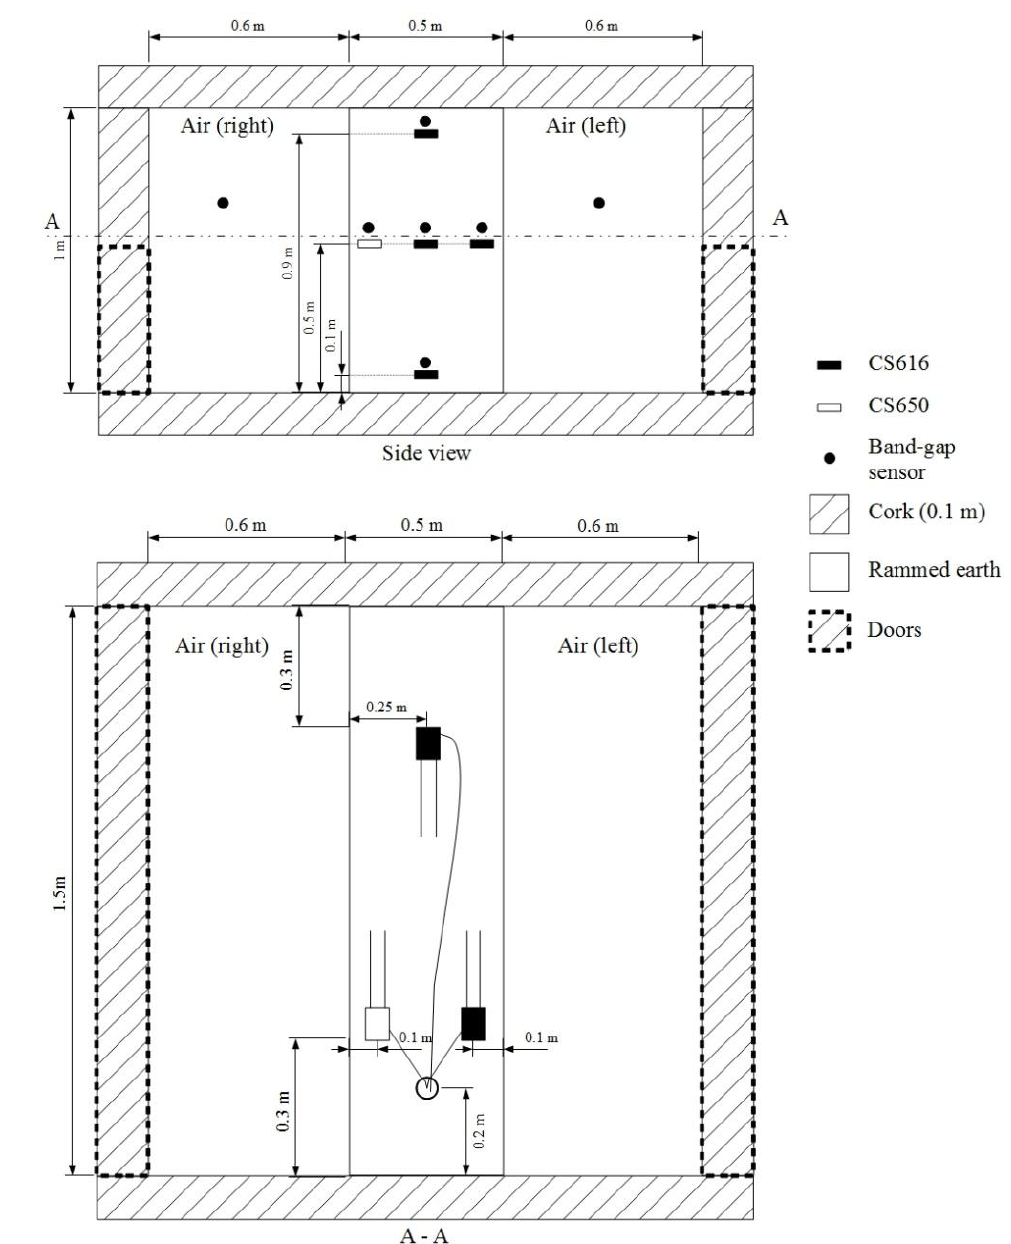
Figure 4. Side view and top view of the implementation of CS616 and CS650 probes in the rammed earth wall placed in a sealed